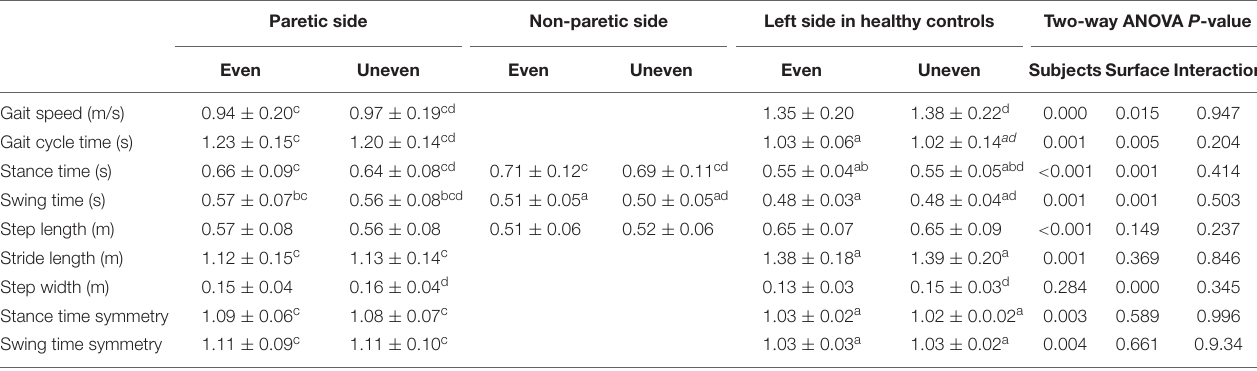
TABLE 3 | The mean and standard deviation of spatiotemporal data in patients after stroke and healthy controls. Paretic side Non-paretic side Uneven Even Uneven Even